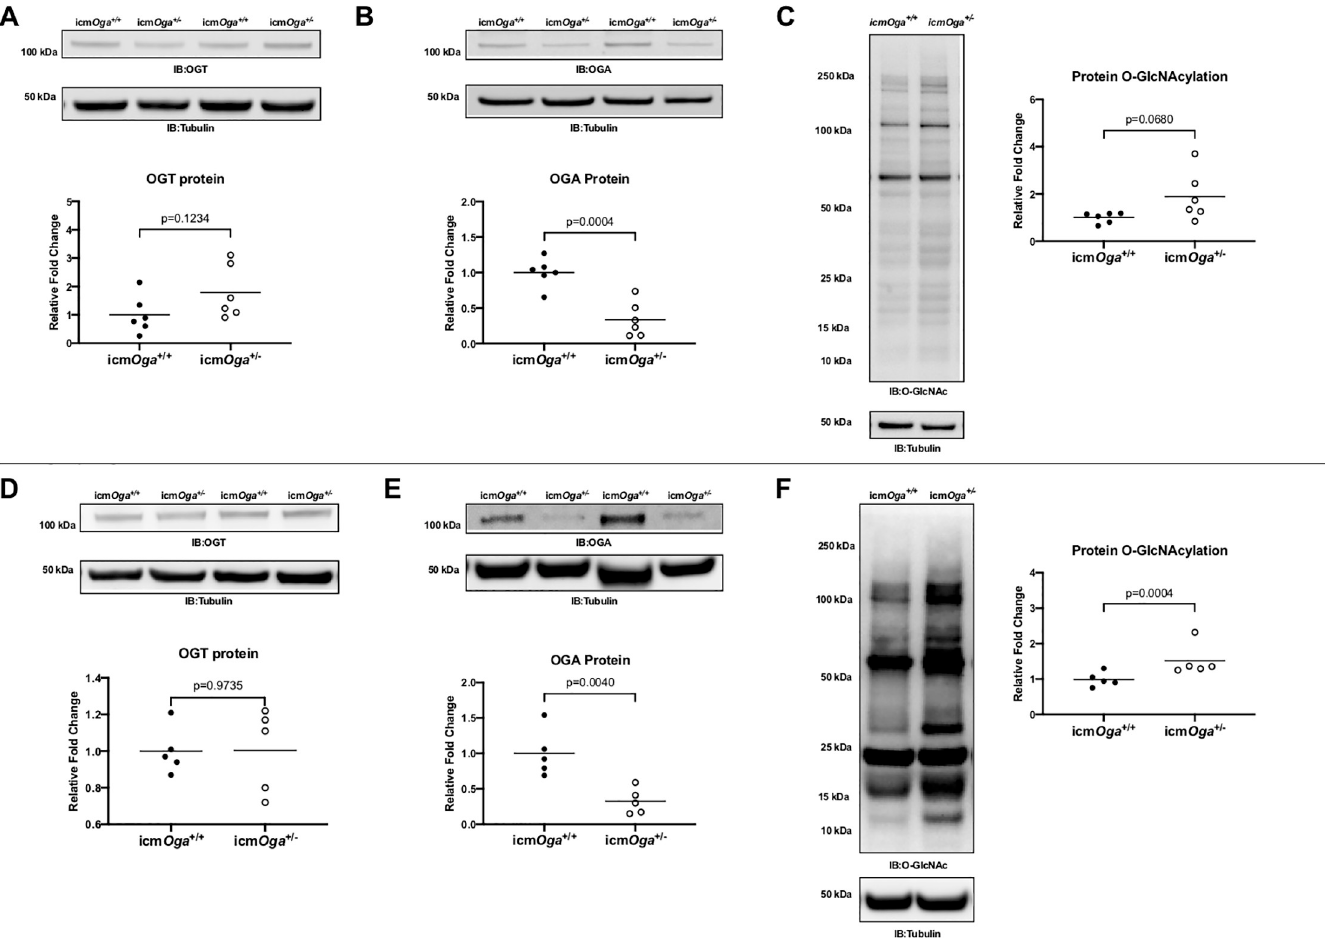
Fig 3. Deficiency of Oga diminishes cardiac OGA. Cardiac tissue harvested from 1 or 4 wk post-MI icm Oga +/+ and icm Oga +/- hearts were probed for OGT, OGA, and protein O-GlcNAcylation. Immunoblot and densitometric analysis for OGT (A), OGA (B), and protein O-GlcNAcylation (C) at 1 wk post-MI. Immunoblot and densitometric analysis for OGT (D), OGA (E), and protein O-GlcNAcylation (F) at 4 wk post-MI. An unpaired Student’s t -test was used to determine significance between icm Oga +/- and icm Oga +/+ groups. affect cardiac function 4 wk post-MI (S5A Fig and S5 Table). Interestingly, the significant dete- rioration in cardiac function at 1 wk-post MI was limited to 1 wk time point. These data indi- cate that the exacerbated cardiac dysfunction exhibited by Oga -deficient mice at 1 wk post-MI was not maintained at 4 wk-post MI.